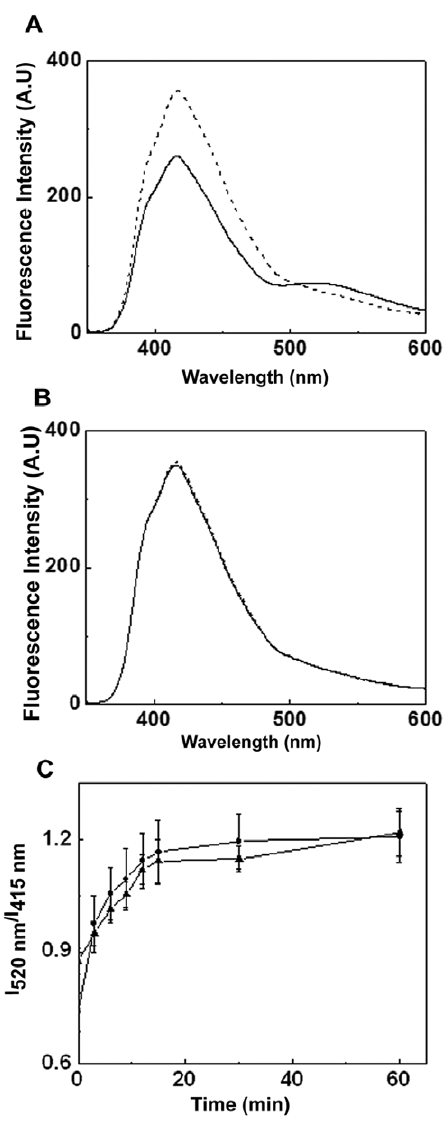
Figure 6. Subunit exchange studies of HspB2 at different temperatures. Subunit exchange at (a) 37 u C (b) 4 u C. The fluorescence spectra immediately after mixing AIAS and LYI labeled HspB2 in equimolar ratios (dotted line) and after 15 min (solid line) are represented. A decrease in AIAS fluorescence intensity with concom- itant increase in LYI fluorescence intensity indicative of subunit exchange is seen when the mixture is incubated at 37 u C. No such change was seen at 4 u C. The rate of subunit exchange at 37 u C ( ( m ) are compared (c). The rates of subunit exchange at these two temperatures are similar.